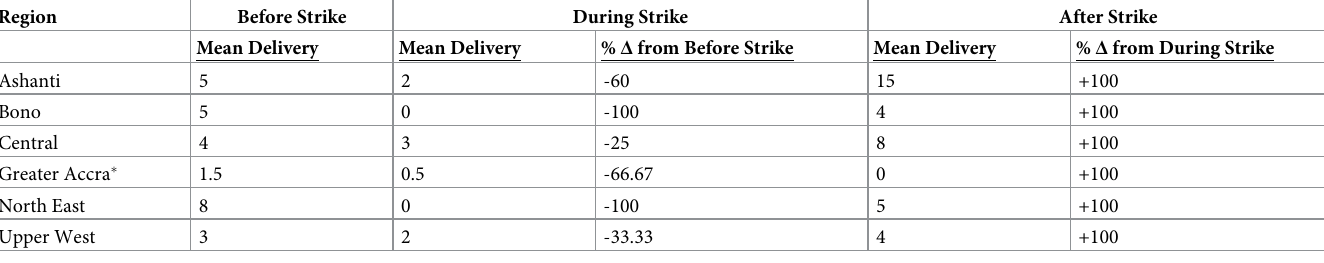
Table 10. Percentage change in deliveries conducted during and after strike. Region Before Strike